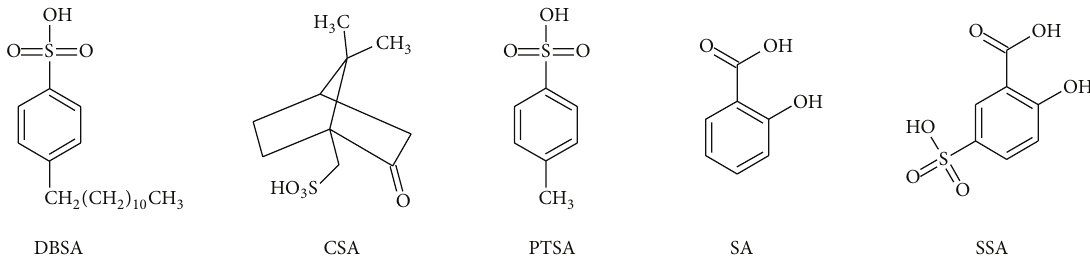
Figure 1: Structure of dodecylbenzenesulfonic acid (DBSA), camphorsulfonic acid (CSA), p -toluenesulfonic acid (PTSA), salicylic acid (SA), and 5-sulfosalicylic acid (SSA).